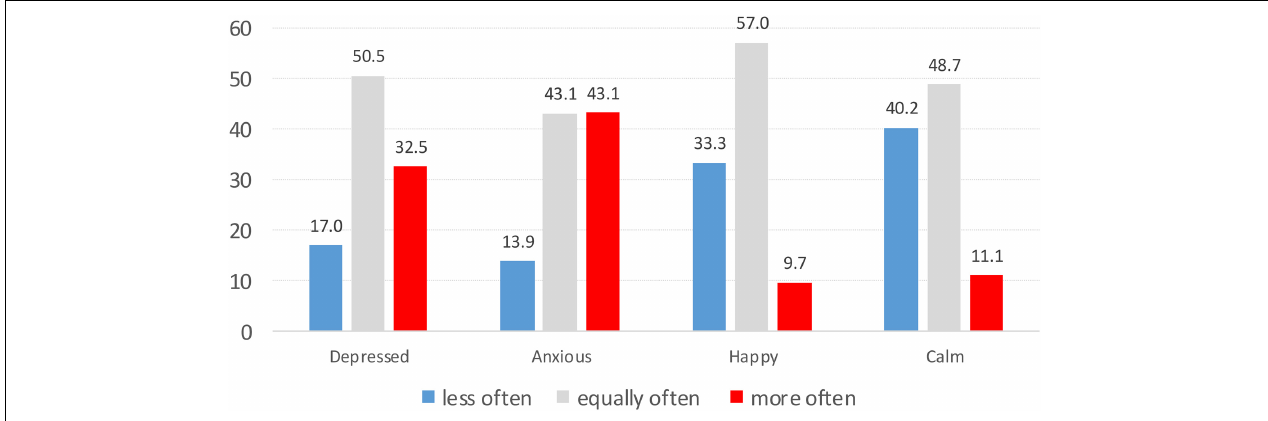
FIGURE 1 | Percentage of participants experiencing feelings indicative of subjective psychological strain (depressed, anxious) and well-being (happiness, calm) less often or more often at the time of the survey than before the COVID-19 lockdown (n Depressed = 5420, n Anxious = 5558, n Happiness = 5750, and n Calm = 5835).